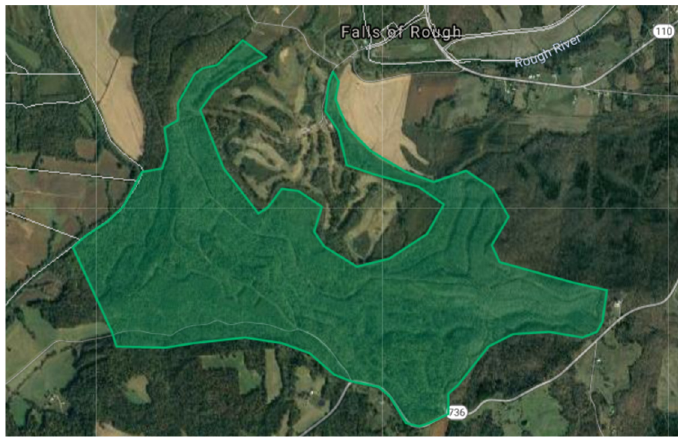
Figure 17 . Property in Falls of Rough, KY [30,34].